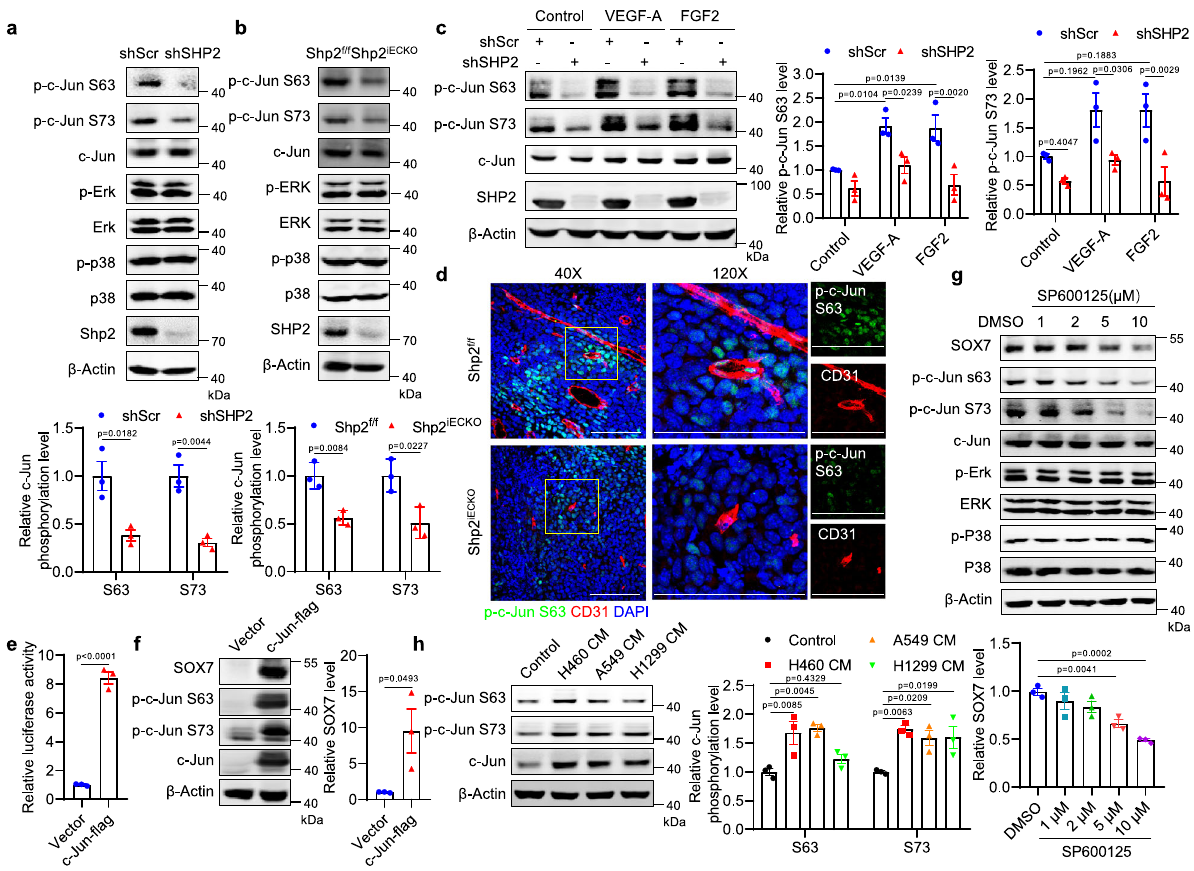
Fig. 6 SHP2 regulates SOX7 expression through c-Jun signaling. a , b Western blot for c-Jun, ERK, and P38 and associated phosphorylated forms in SHP2- knockdown HUVECs and MLECs isolated from Shp2 f/f and Shp2 iECKO mice. β -Actin was used as a loading control. Quantitative data were shown as mean ± SEM for three independent experiments. p -values were shown and generated by one-way ANOVA with multi-comparisons or the two-tailed Student ’ s t -test. c Western blot for c-Jun and associated phosphorylated forms in SHP2 knockdown and control HUVECs treated with VEGF-A (10 ng/ml) or FGF2 (10 ng/ml) for 10 min. β -Actin was used as a loading control. Quantitative data were shown as mean ± SEM for three independent experiments. p -values were shown and generated by two-way ANOVA with Bonferroni ’ s multiple comparisons test. d Representative images showing p-c-Jun S63 level (green) in CD31 + vessels (red) in LLC tumors in Shp2 f/f ( n = 5) and Shp2 iECKO ( n = 5) mice. Scale bar: 50 μ m; inset 100 μ m. e Luciferase reporter assay in HEK293 cells with c-Jun overexpression. The data were normalized to the Renilla luciferase activity. Quantitative data were shown as mean ± SEM for three independent experiments. p -value was shown and generated by the two-tailed Student ’ s t -test. f , g Western blot for SOX7, c-Jun, and its phospho-forms in HEK293 cells with c-Jun overexpression ( f ) and SOX7, c-Jun, phosphor-c-Jun, ERK, phosphor-ERK, P38, and p-P38 in HUVECs treated with various concentrations of JNK inhibitor SP600125 (24 h) ( g ). β -Actin was used as a loading control. Quantitative data were shown as mean ± SEM for three independent experiments. p -values were shown and generated by using the two-tailed Student ’ s t -test or by one-way ANOVA with multi-comparisons. h Western blot for c-Jun and associated phosphorylated forms in HUVECs treated with various NSCLC cancer cell-conditioned media for 24 h. β -Actin was used as a loading control. Quantitative data were shown as mean ± SEM for three independent experiments. p -values were shown and generated by one- way ANOVA with multi-comparisons. Source data are provided as a Source data fi